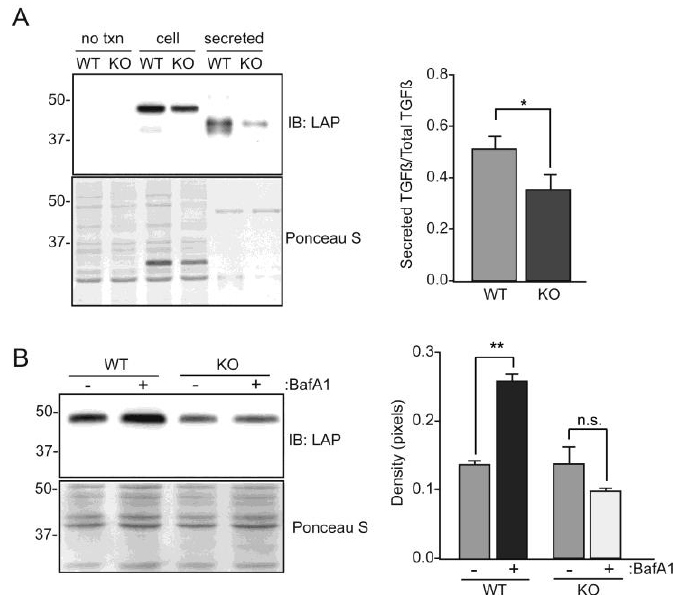
Figure 7. Expression of latent TGF β 1 in GNPTAB - / - HeLa cells modestly lowers latent TGF β 1 secretion. ( A ) WT and GNPTAB - / - HeLa cells were transfected with DNA encoding the TGF β 1 precursor and Western blot analysis performed on cell lysates or media. Immunoblots were subsequently stained with Ponceau S as a loading control. The relative amount of latent TGF β 1 to total TGF β 1 in the cell lysates and media (secreted) fractions was quantified (n = 3), * p ≤ 0.05. ( B ) WT and GNPTAB - / - HeLa cells transfected with TGF β 1 precursor cDNA were treated with or without bafilomycin A1 and cell lysates subjected to SDS-PAGE and Western blot analysis. The abundance of latent TGF β 1 protein in cell lysates is plotted (n = 3), ** p ≤ 0.01.